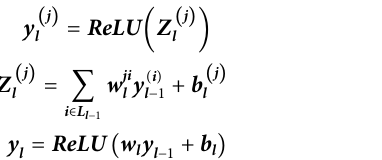
classi fi cation accuracy on structured data. The goal of structured data qualitative is to classify the color status of sample images. Con fi dence is a criterion to judge whether the